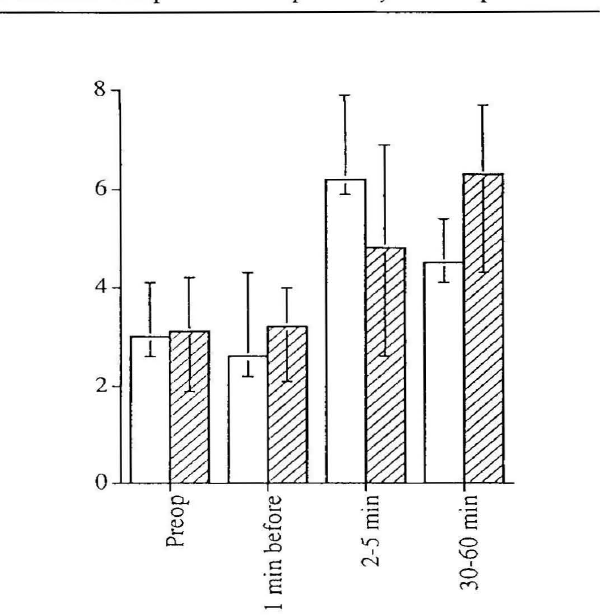
Figure 1. Neopterin in patients undergoing orthotopic liver transplantation. Concentrations in patients operated upon the use of a veno-venous bypass (open bars) and those without a bypass (filled bars). The results are given as median and 25th-75th